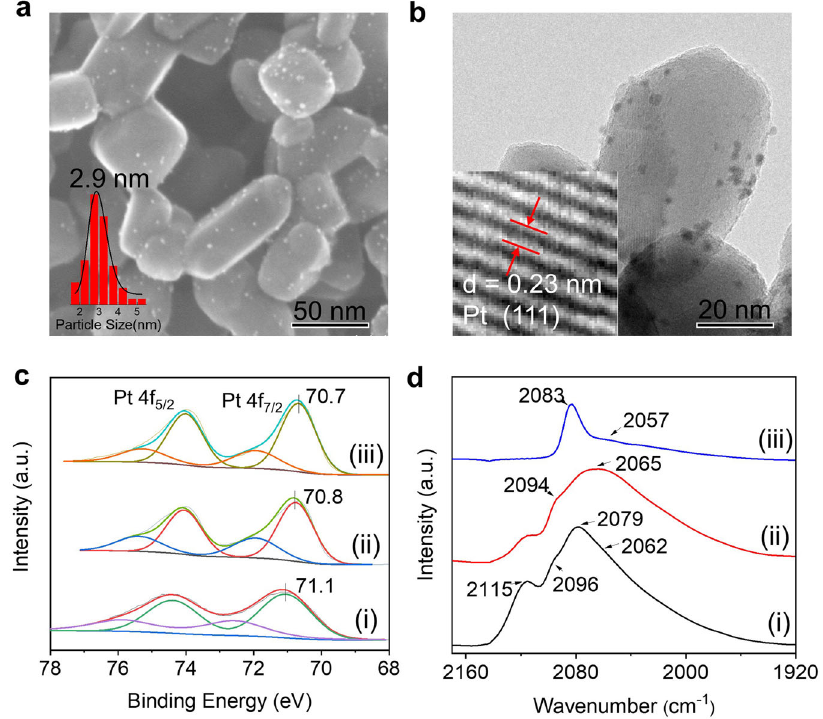
Fig. 2 Characterization of Pt/TiO 2 catalysts. a HRSEM image and b HRTEM image of Pt/TiO 2 . c Pt 4f XPS core level spectra and d CO DRIFTS results for ( i ) Pt/TiO 2 , ( ii ) Pt/TiO 2 -200, and ( iii ) Pt/TiO 2 -450.